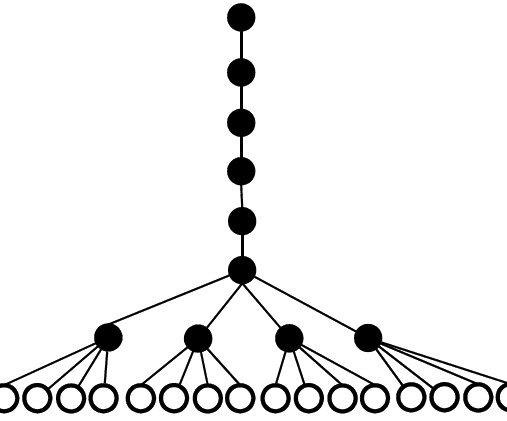
Figure 10. Thin trees with fewer participating nodes Figure 10 . Thin trees with fewer participating nodes [53].